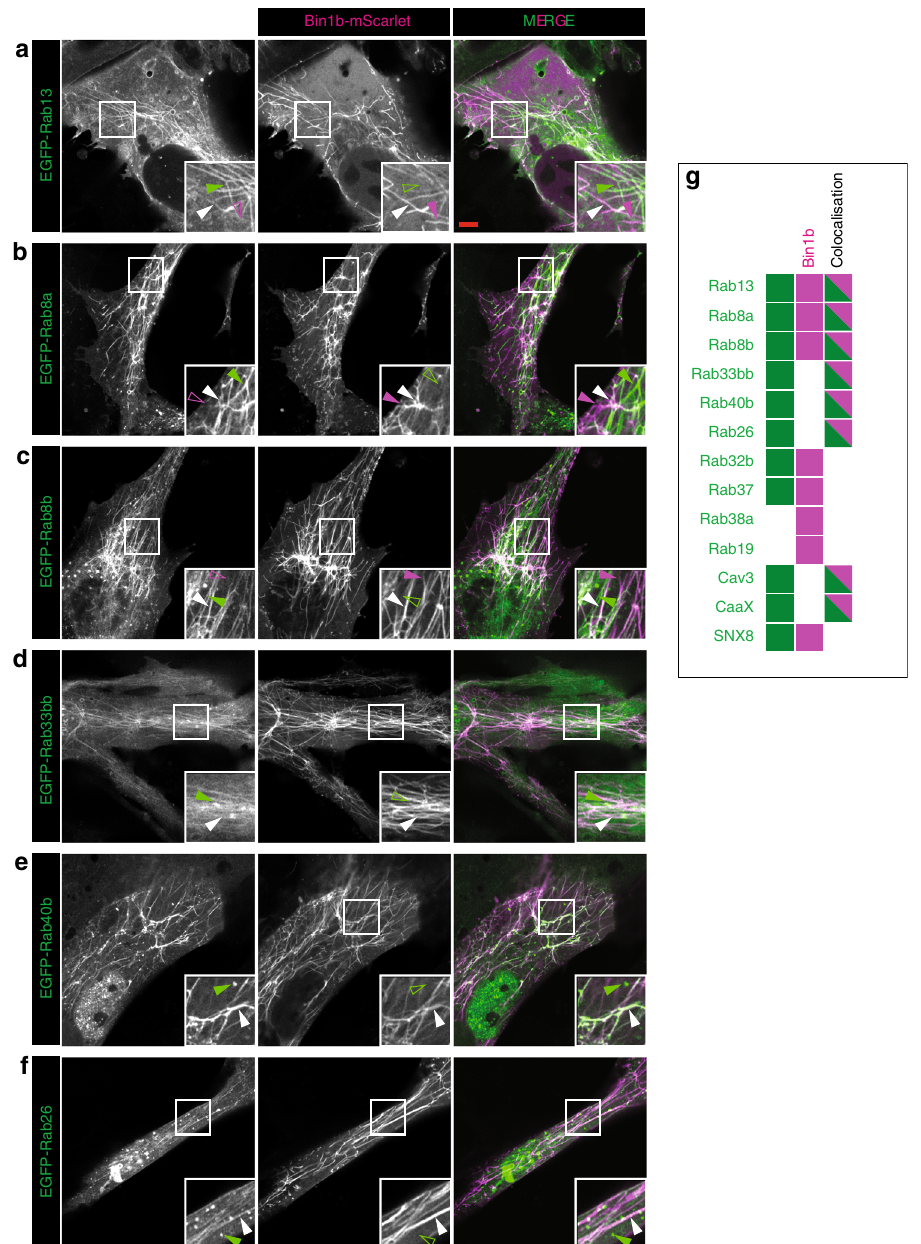
Fig. 9 An in vitro model of T-tubule formation. ( a ) Rab13, ( b ) Rab8a, ( c ) Rab8b, ( d ) Rab33bb, ( e ) Rab40b, ( f ) Rab26, ( g ) summary graphic showing cells that possess tubules with Bin1b only (magenta), marker only (green) and tubules where bin1b colocalizes with the marker (dual colour; (see also Supplementary Fig. 9). Images are representative of three individual cells imaged within the same